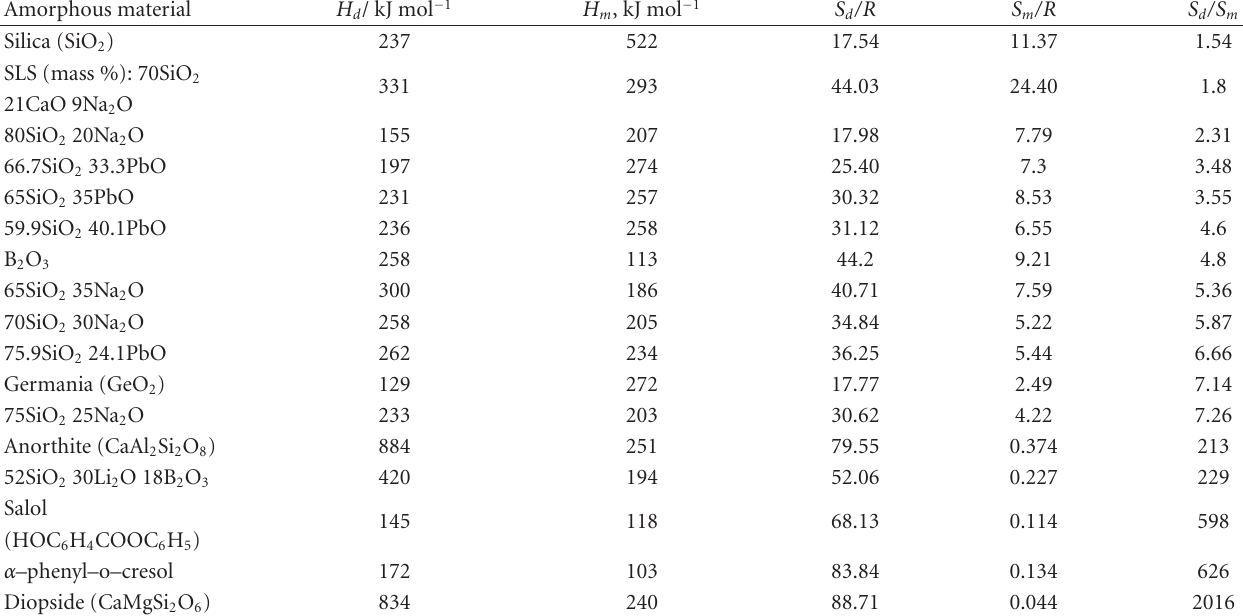
Table 4: Thermodynamic parameters of